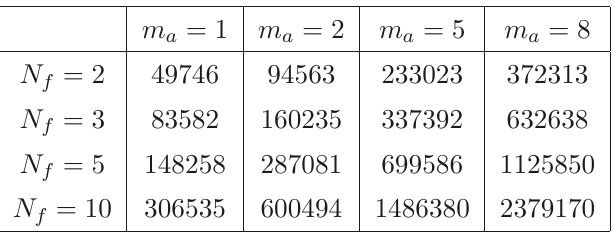
Table 1 . The free energies correspond to the real